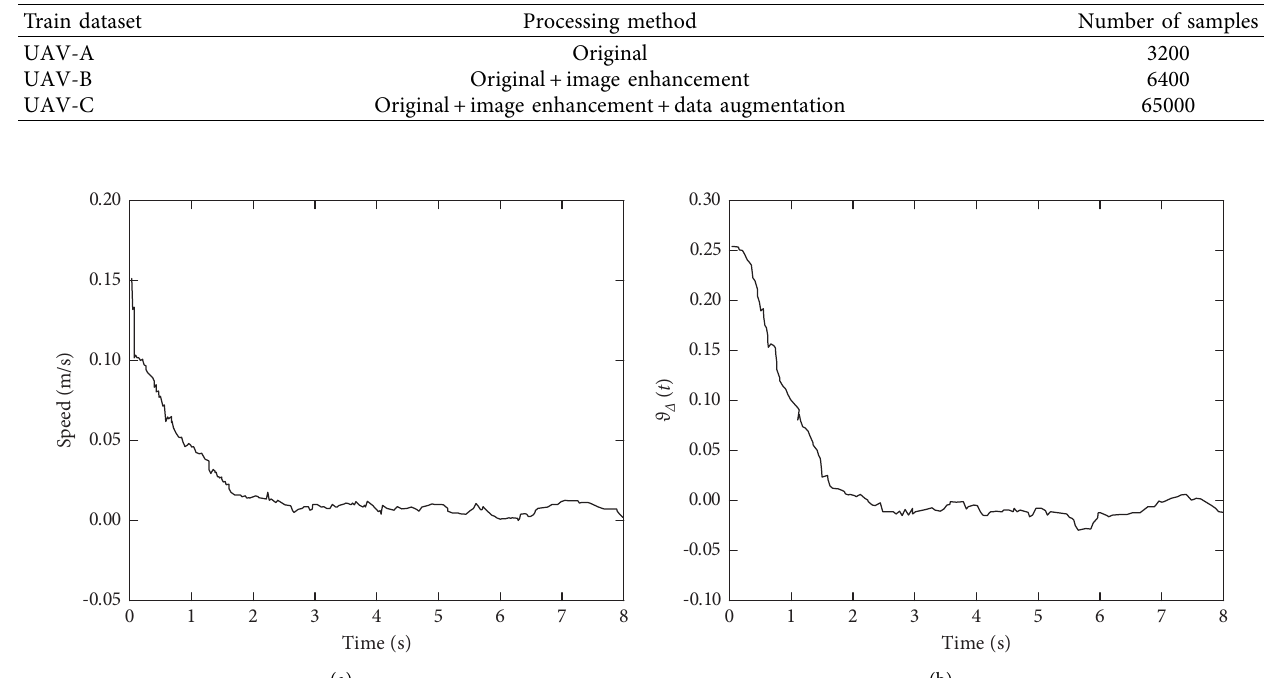
Table 1: Processing methods and sample numbers of different training sets.